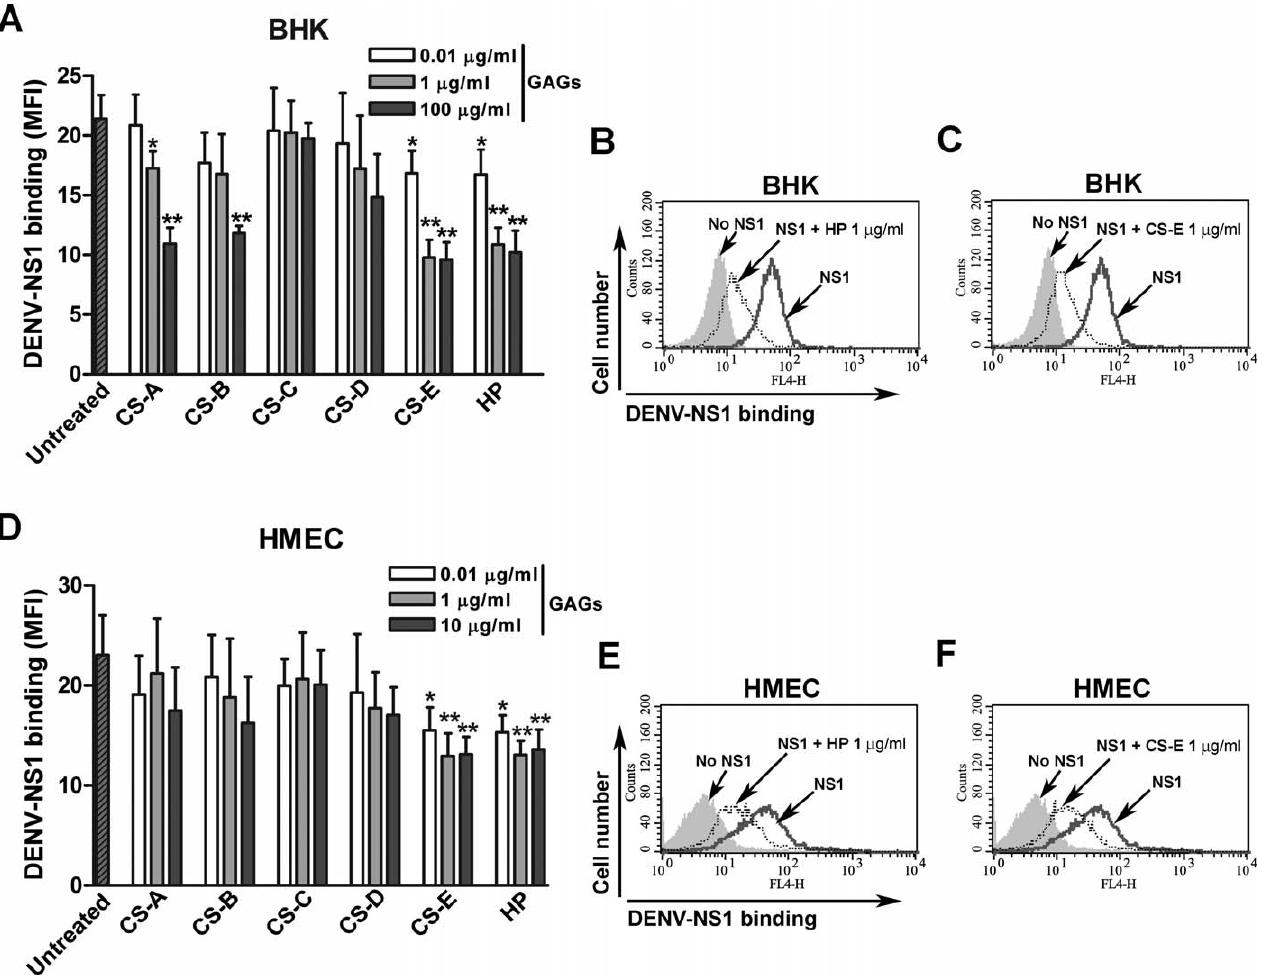
Figure 4. Soluble HP and CS-E Block DENV NS1 Binding to the Surface of BHK and HMEC DENV NS1 was incubated with three concentrations of indicated soluble GAG prior to incubation with (A–C) BHK or (D–F) HMEC. DENV NS1 was detected by flow cytometry (as described in Figure 2). Data are expressed as the specific MFI of staining as described in Figure 3. The error bars indicate SD corresponding to three independent experiments. Asterisks denote NS1 binding that is statistically different from untreated cells (* p , 0.05, ** p , 0.005). Examples of histogram profiles in which soluble HP and CS-E at 1 l g/ml concentration block DENV NS1 binding to the surface of (B–C) BHK and (E–F) HMEC are depicted.